Question: Author a descriptive caption for the visualization shown.
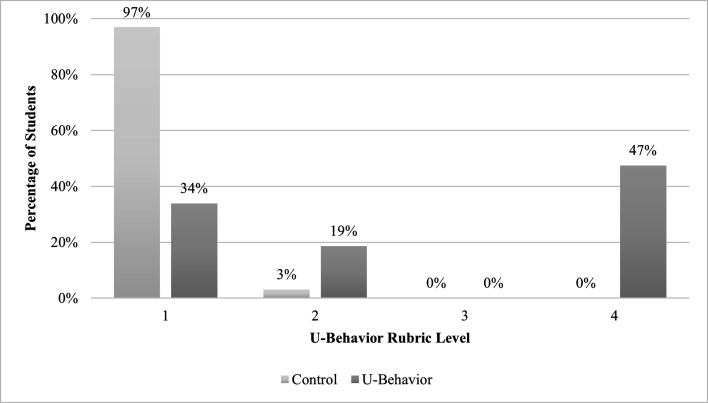
Answer: VMBS 100: distribution of UB-rubric scores. Note : Distribution of U-Behavior rubric levels in the control and U-Behavior conditions in VMBS 100. See also Table 4 for within-UB exam performance by rubric level.